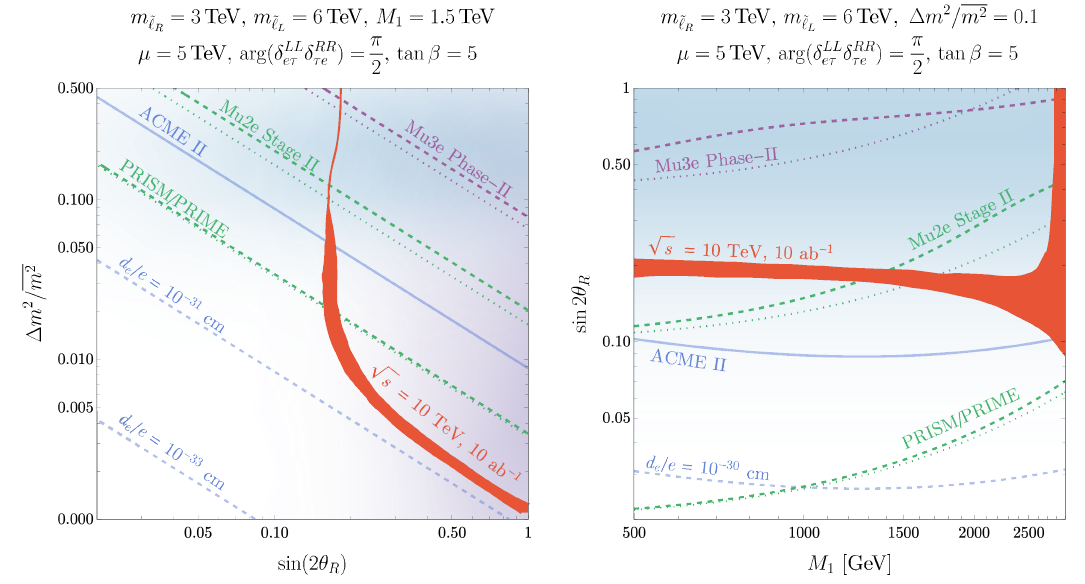
Figure 10. Complementarity of a 10 TeV muon collider with EDM and µ → eγ experiments. This figure is similar to figure 6, but also shows the electron EDM and µ → eγ effects from the stau mixing contributions shown in figure 9. The solid blue curve displays the constraint from the current ACME II experiment [96]. The dashed blue curves show hypothetical future EDM constraints. The dotted green and purple curves are the low-energy LFV constraints from figure 6, while the dashed green curves add the effects from stau mixing. We see that the stau mixing effect, being quadratic in δ , is only important at larger δ